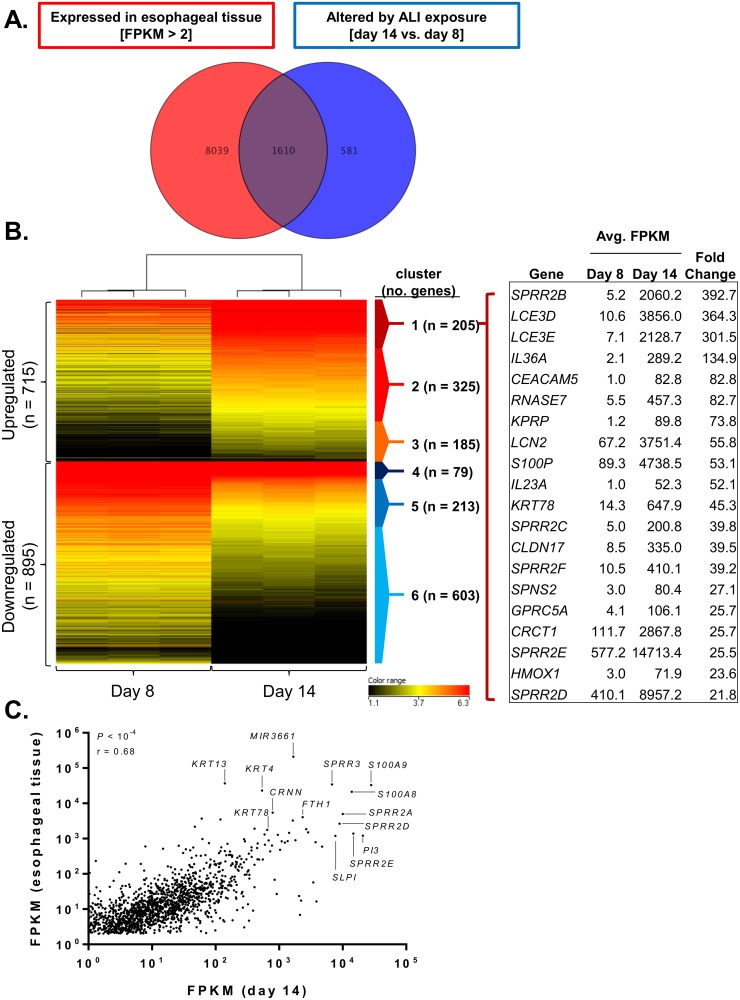
In vitro ALI differentiation replicates gene signature of healthy tissue ex vivo.Venn diagram depicting the number of genes expressed in healthy esophageal tissue (FPKM > 2, n = 9,649) and the number of genes altered during air-liquid interface (ALI) differentiation (day 14 compared to day 8, n = 2,191) (P < 0.05, fold change > 2.0) (A). Clustered heatmap showing the log2 FPKM values of the 1,610 genes in common to both data sets. Also shown are the 20 most dysregulated genes in cluster 1 (induced at day 14) (B). Expression (FPKM) correlation for the 1,610 genes in common between the healthy esophageal tissue and genes altered during ALI differentiation (C).